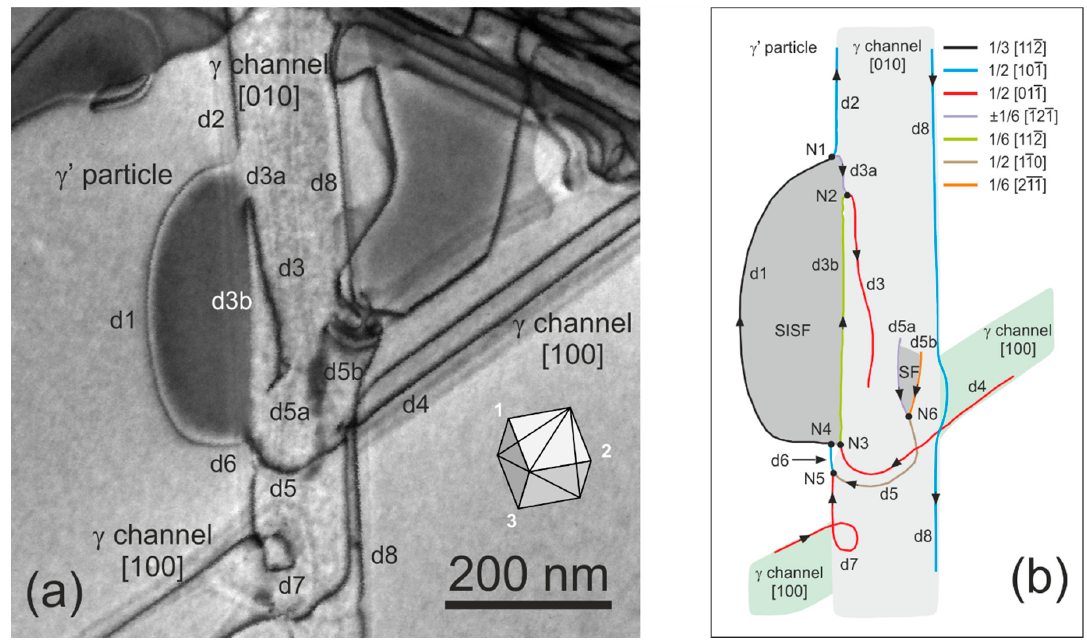
Figure 7. STEM results and schematic illustrations of dislocation reactions, which are involved in forming planar fault. ( a ) Experimental STEM image. ( b ) Identification of Burgers vectors and orientations of dislocation line segments (d1 to d8). Nodes N1 to N6 indicate locations where dislocation reactions have taken place. Table 3. Effective visibilities (+) and invisibilities (-) for g -vectors 2 to 6 from Table 2.